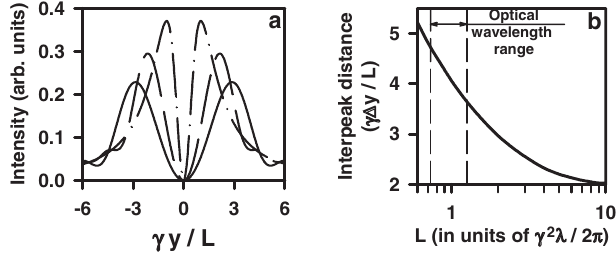
FIG. 5. (a) TR spatial distribution at x (cid:5) 0 in the PWZ calcu- lated for different target-to-detector distances: L (cid:5) 10 (cid:1) 2 (cid:2)= 2 (cid:3) (cid:5) 5 m (dash-dotted line), L (cid:5) 0 : 9 (cid:1) 2 (cid:2)= 2 (cid:3) (cid:5) 0 : 45 m (dashed line), and L (cid:5) 0 : 5 (cid:1) 2 (cid:2)= 2 (cid:3) (cid:5) 0 : 25 m (solid line). (b) Interpeak distance calculated in units of 1 =(cid:1) as a function of the target-to-detector distance. Calculation parame- (cid:5) 9 mm , b (cid:5) 7 mm , a (cid:5) ters: (cid:1) (cid:5) 2500 , (cid:2) (cid:5) 500 nm , a s out out (cid:5) 0 , (cid:6) (cid:5) 45 (cid:14) , and j R j 2 (cid:5) 0 : 37 . Since the target-to-detector b s y 0 distance is represented in relative units, we can easily identify the range corresponding to the optical